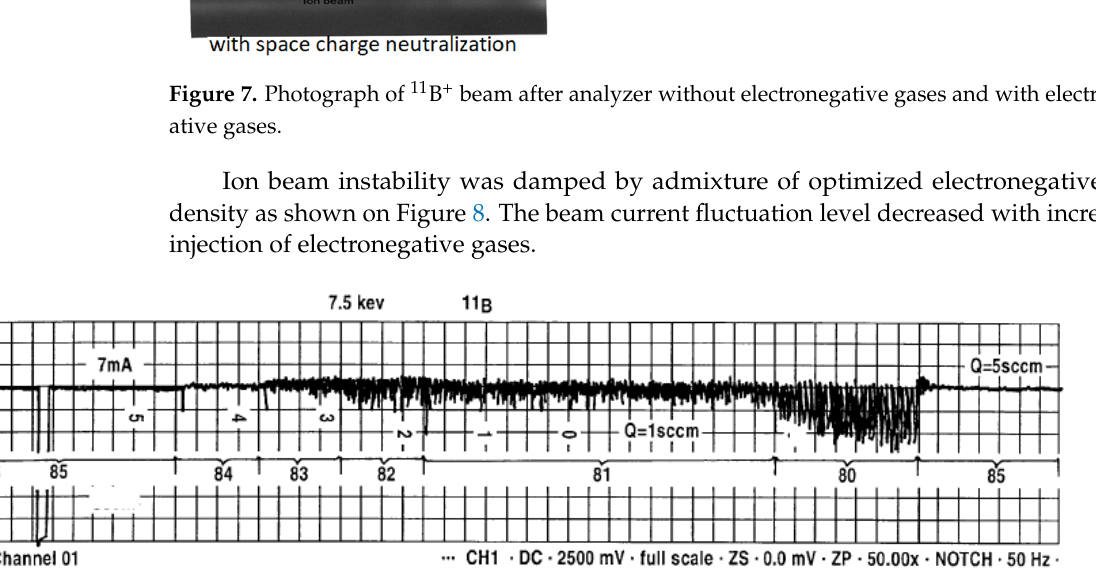
Figure 8. Ion beam current after analyzer showing damping of beam instability by injection of different quantities of electronegative gas. Q is in sccm (standard cubic centimeters per minute).